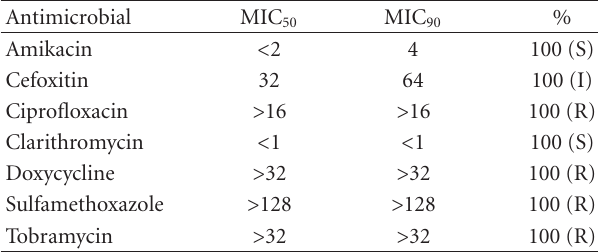
Table 1: Antimicrobial susceptibility of 18 Mycobacterium mas- siliense strains recovered from wound infections after arthroscopic and laparoscopic surgeries during an outbreak in Goiˆania, Goi´as,